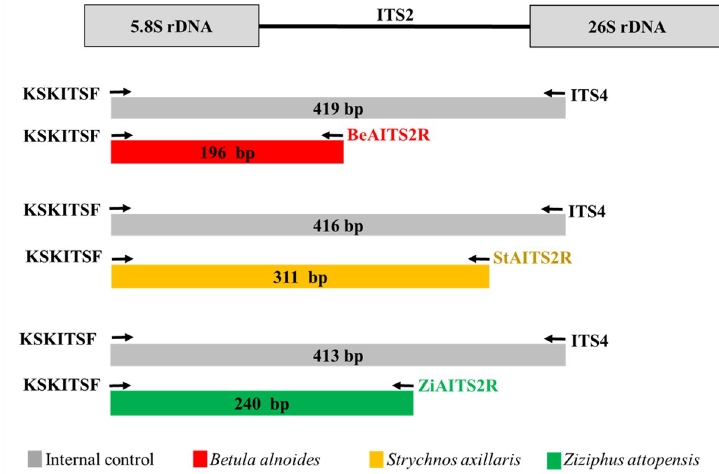
Fig 5. Amplification fragment sites of species-specific primer sets for the internal control, B . alnoides , S . axillaris , and Z . attopensis . The arrow indicates the orientations and approximate positions of the species-specific primers. The gray, red, yellow, and green bars represent the PCR products from multiplex PCR. of BA1, 416 and 311 bp of SA1, 413 and 240 bp of ZA1 as internal controls and species-specific amplicons, respectively. For the negative control, only the internal control amplicon was detected. These obtained results corresponding to the expected results (Fig 5) indicated that all designed primers were proper to identify CK1-CK5. The amplicons from the multiplex PCRs of CK1-CK5 in Fig 6A and S3 Fig also comprised 2 fragments, the upper and lower bands. All